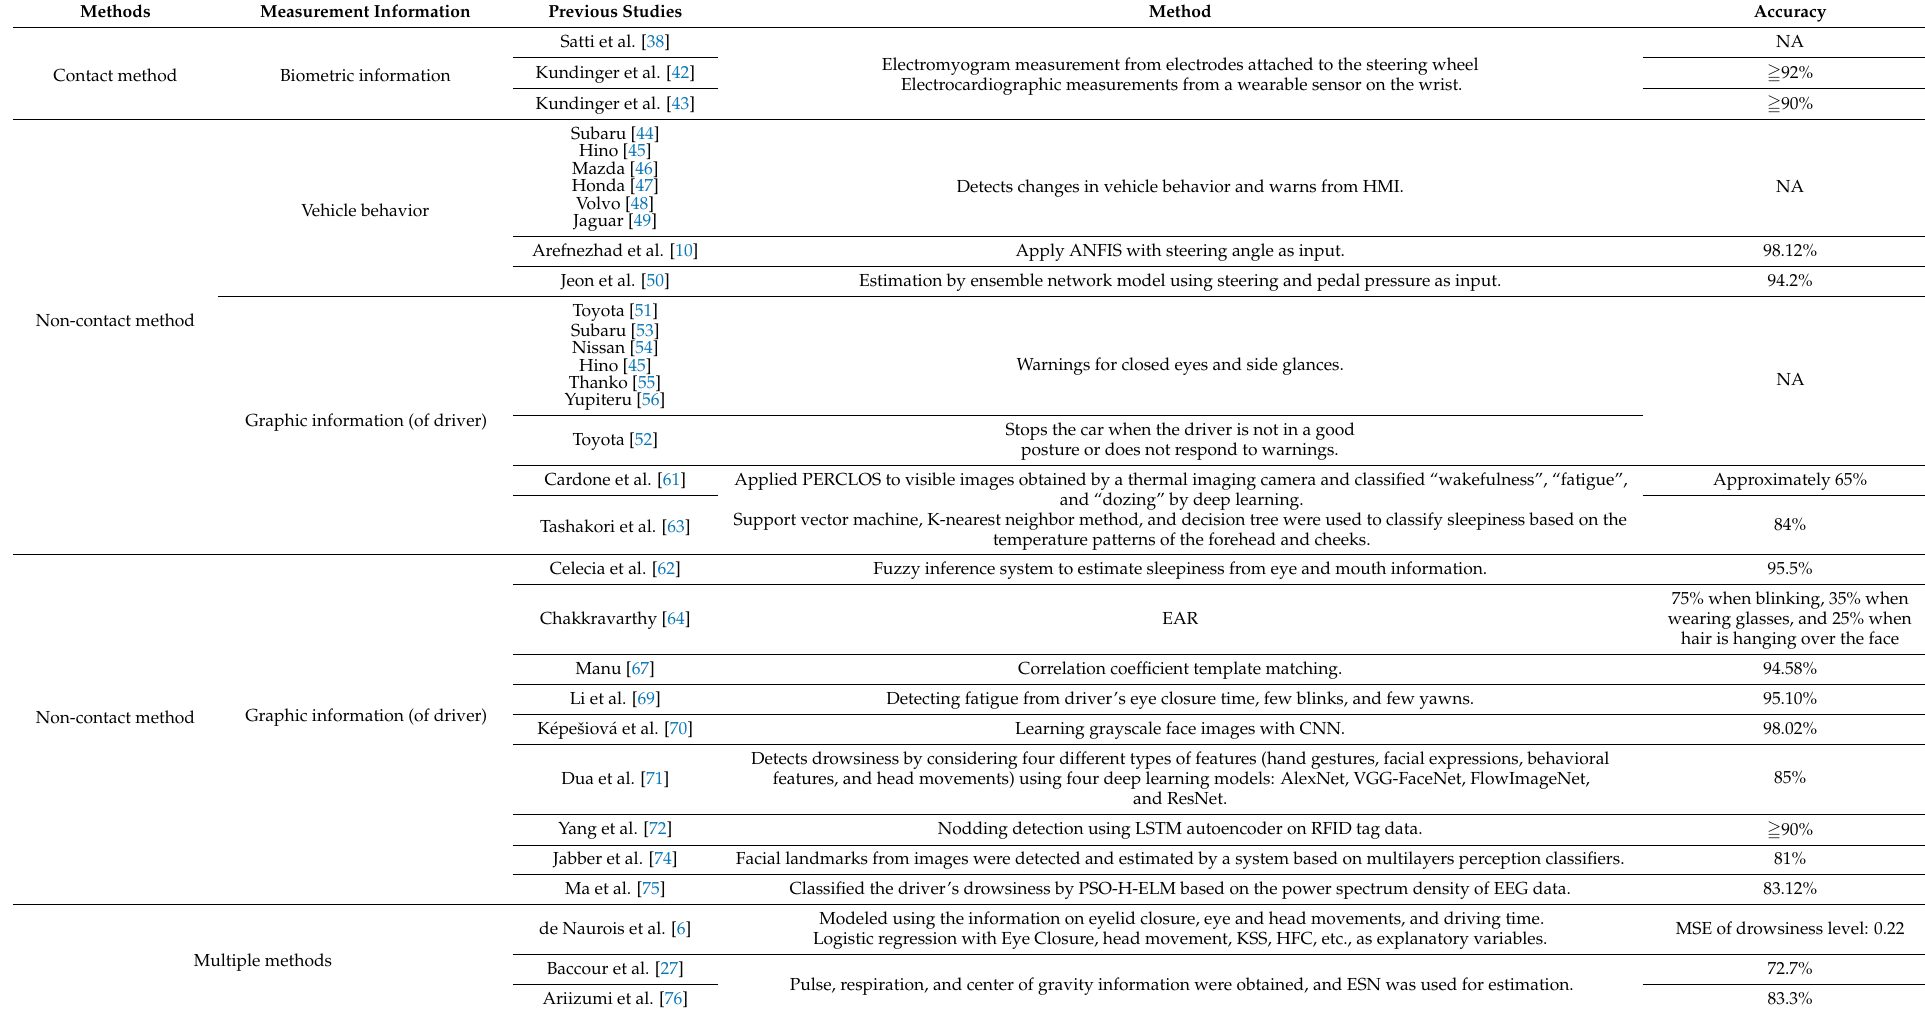
Table 5. Summary of the technologies discussed in this paper. NA means that the accuracy could not be ascertained within the